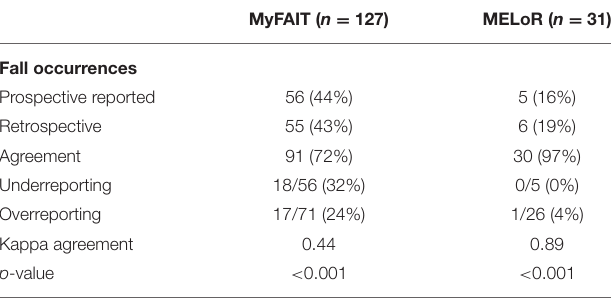
TABLE 2 | Agreement between prospective and retrospective falls